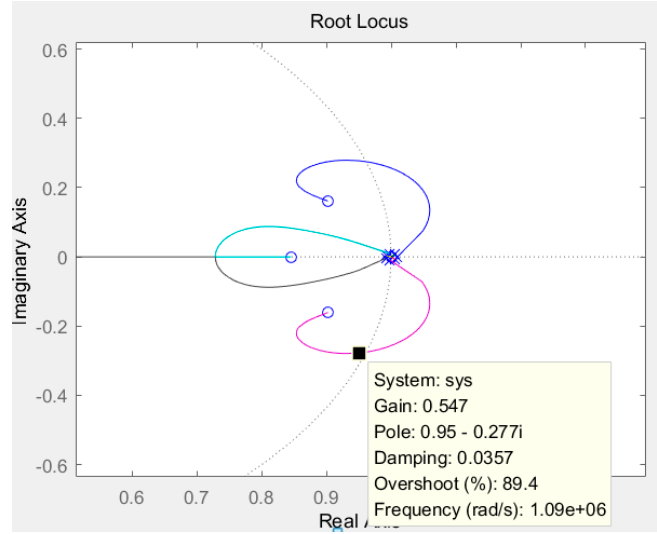
Figure 7. Root locus of the Sigma-Delta modulator.